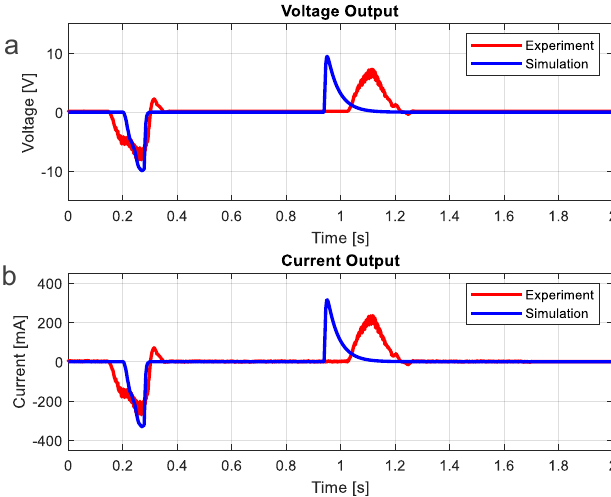
Figure 8. Voltage and Current of Rack-Pinion Model from Experiment and Simulation. ( a ) Voltage of Rack-Pinion Model. ( b ) Current of Rack-Pinion Model.